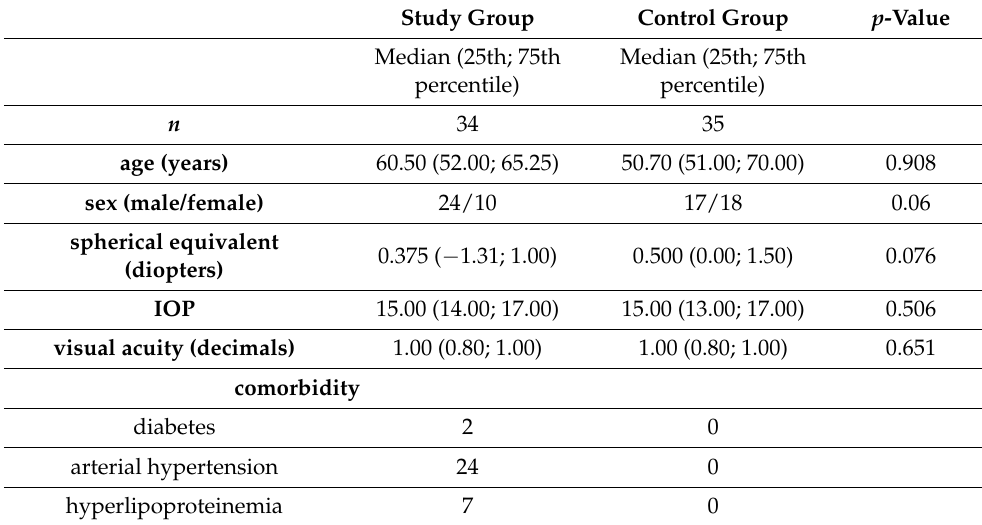
Table 1. Characteristics of the study population. AF = atrial fibrillation. IOP = intraocular pressure.